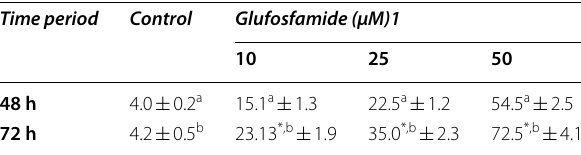
Table 4 Effects of glufosfamide on caspase-9 content in cell lysate of cultured HepG2 cells